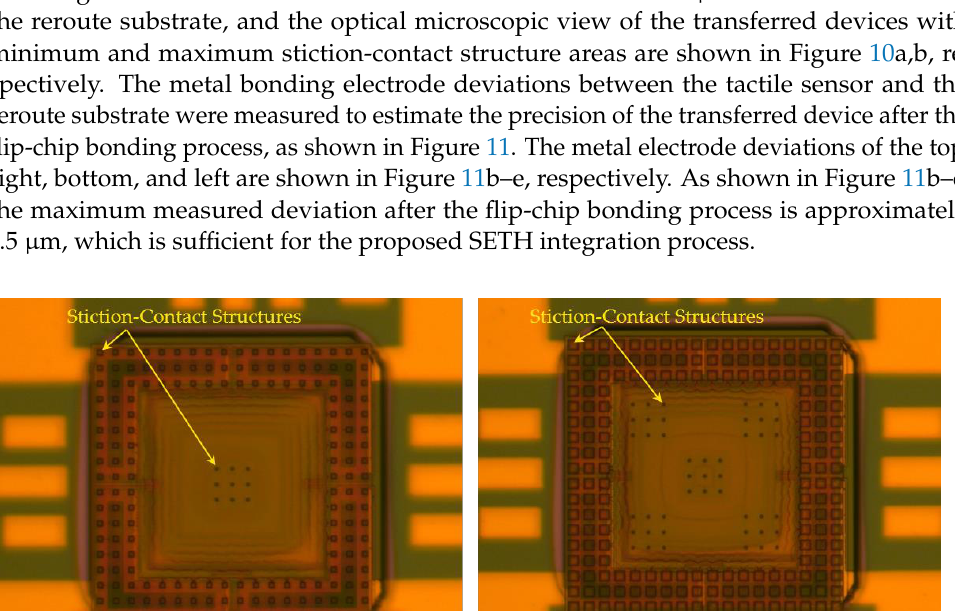
( b ) Figure 9. Scanning electron microscopy (SEM) view of the temporary supported beam of the fabri-